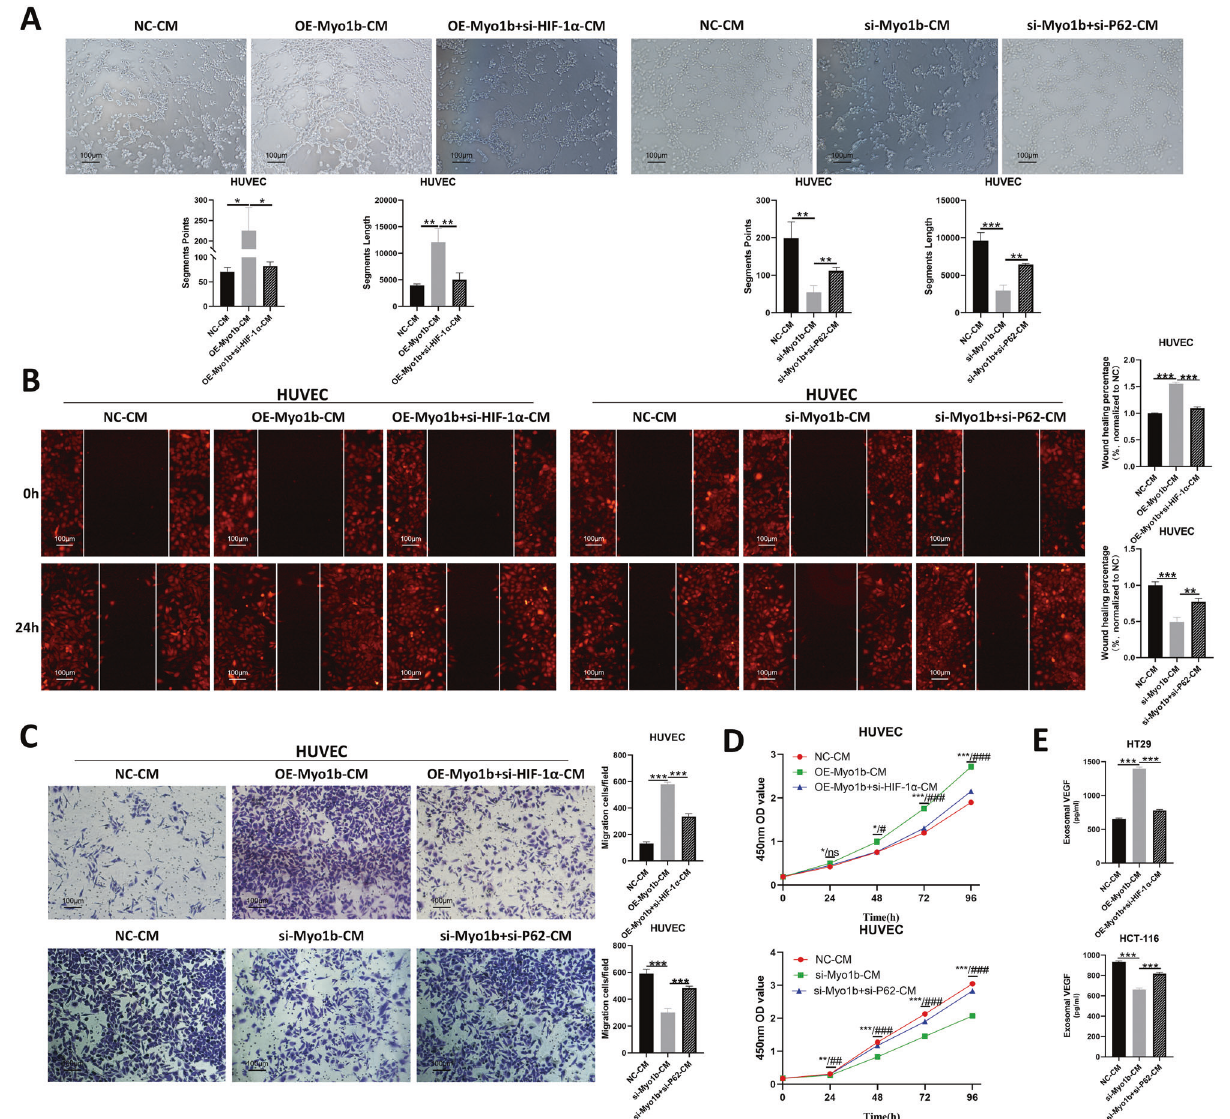
Fig. 5 HIF-1 α participated in the angiogenesis function of Myo1b in CRC. A Effects of si-P62 and si-HIF-1 α on Myo1b mediated angiogenesis was analyzed through HUVEC tube formation assay. Wound healing assay (B) and transwell migration assay (C) were performed to explore the effects of si-P62 and si-HIF-1 α on Myo1b mediated HUVEC migration. D Effects of CM treatment collected from indicated cells on HUVEC proliferation was evaluated by Cell Counting Kit-8 assays. E Effects of si-P62 and si-HIF-1 α on Myo1b mediated VEGF secretion of HCT-116 and HT29 cells were measured using ELISA assay. Each bar represented the mean ± SD ( n ≥ 3). *, **, ***: NC-CM VS OE-Myo1b-CM; #, ##, ###: OE- Myo1b-CM VS OE-Myo1b + si-HIF-1 α -CM. *, #, p < 0.05; **, ##, p < 0.01; ***, ###, p <